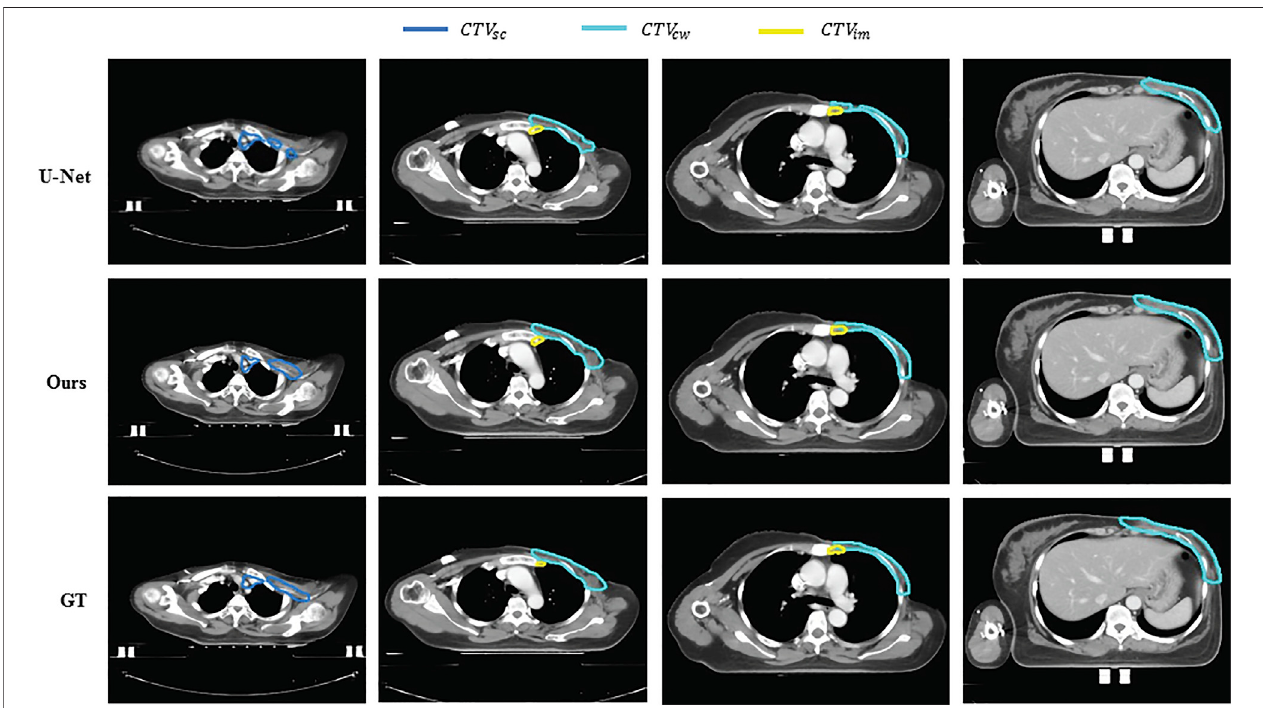
FIGURE 4 | Examples of segmentation results of U-Net and the proposed method against gold standard for the affected side. Different colors represent different segmentationtargets.The fi rstrowistheresultofU-Net,thesecondrowistheresultofourmethod,thethirdrowisthegroundtruthoftheimages.Andthedifferentcolors represent dfferent segmentation targets. Blue meas the supra-clavicular region, yellow means internal mammary lymphatic region (CTV im), another means CTV in the chest wall (CTV cw).